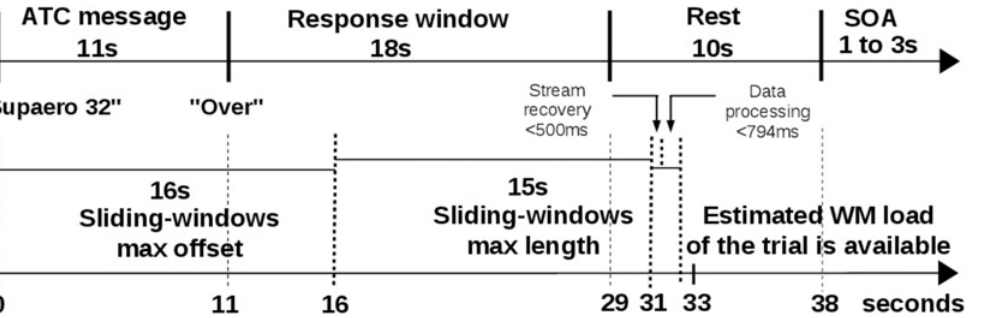
Fig 10. Trial timeline and computing latencies. The upper timeline shows ATC span task trial events duration (see Fig. 3). Bottom timeline illustrates duration constraints to get pilot ’ s estimated WM load: classifier ’ s response is available in the worst case less than 3.3 s after pilot ’ s response window.